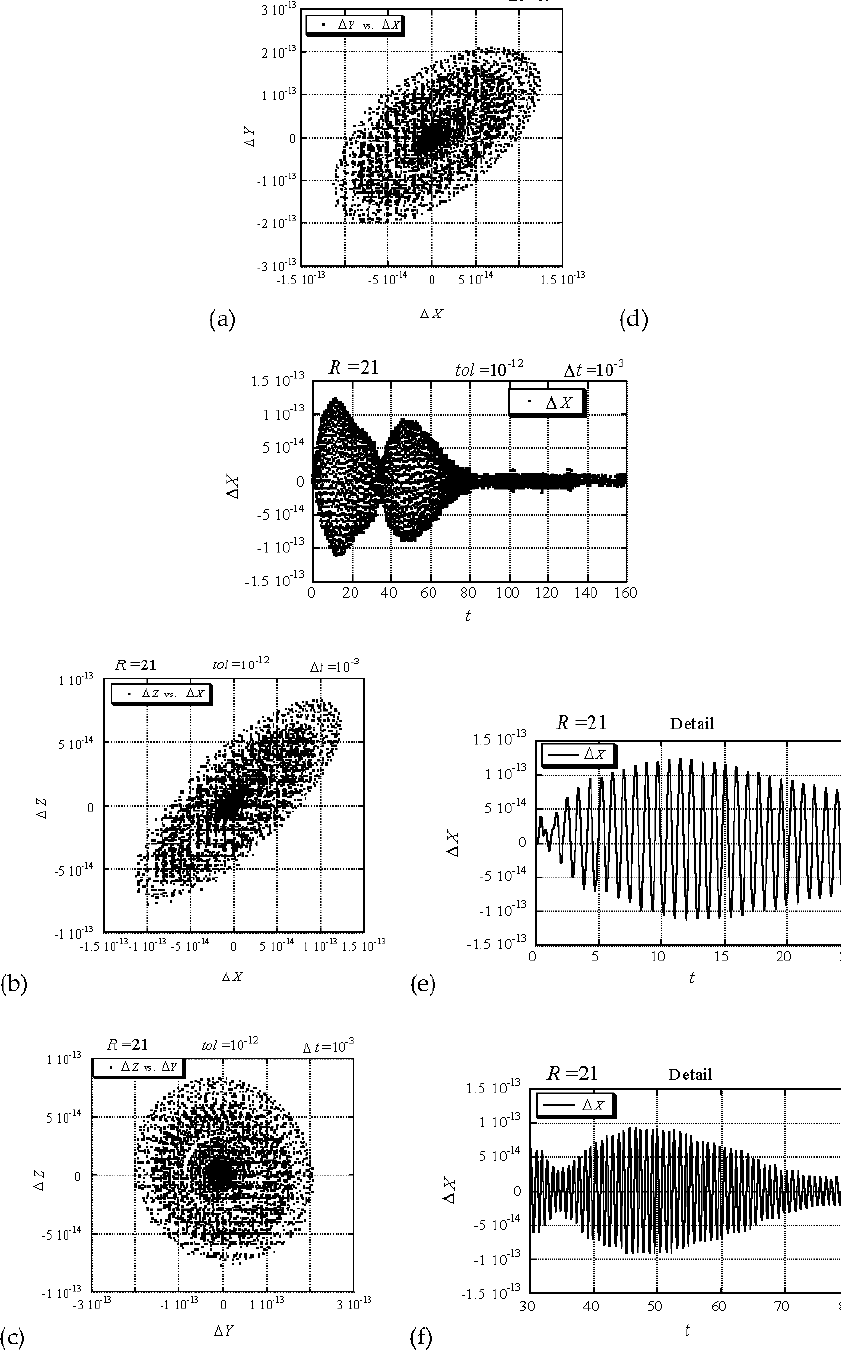
Figure 10. Trajectory of differences between the computational (Adomian decomposition) and numerical (Runge-Kutta) solutions corresponding to ∆ t = 10 − 3 in the computational solution, tol = 10 − 12 in the numerical solution, and R = 21. ( a ) projection of trajectory’s data points on the plane ∆ Z = 0; ( b ) projection of trajectory’s data points on the plane ∆ Y = 0; ( c ) projection of trajectory’s data points on the plane ∆ X = 0; ( d ) the solution of ∆ X ( t ) projected on the time domain; ( e ) inset of the solution ∆ X ( t ) projected on the time domain for 0 < t < 25; ( f ) inset of the solution ∆ X ( t ) projected on the time domain for 30 < t < 80. (Except for Figure 10e,f, the data points are not connected) [11]. (Reproduced with permission from Peter Vadasz, Shmuel Olek, International Journal of Heat and Mass Transfer; published by Elsevier,